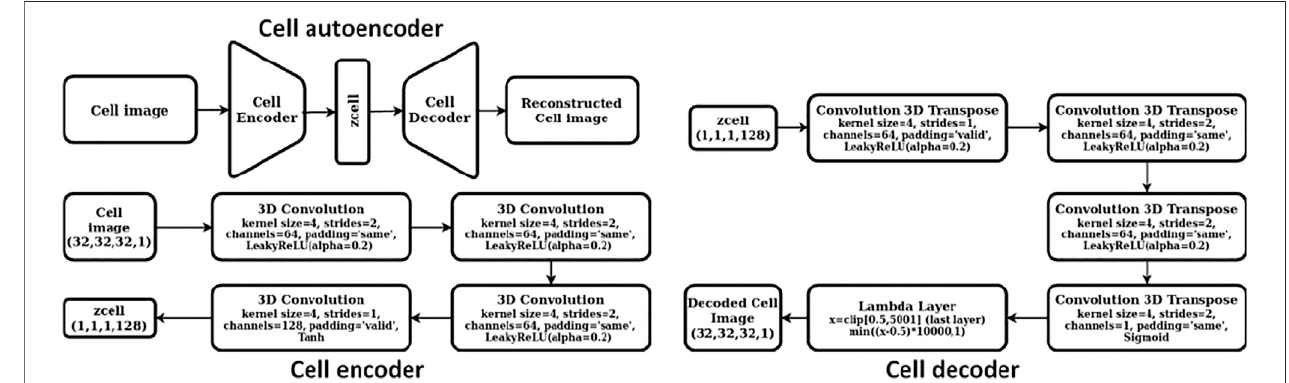
FIGURE 2 | Architecture of the cell autoencoder.